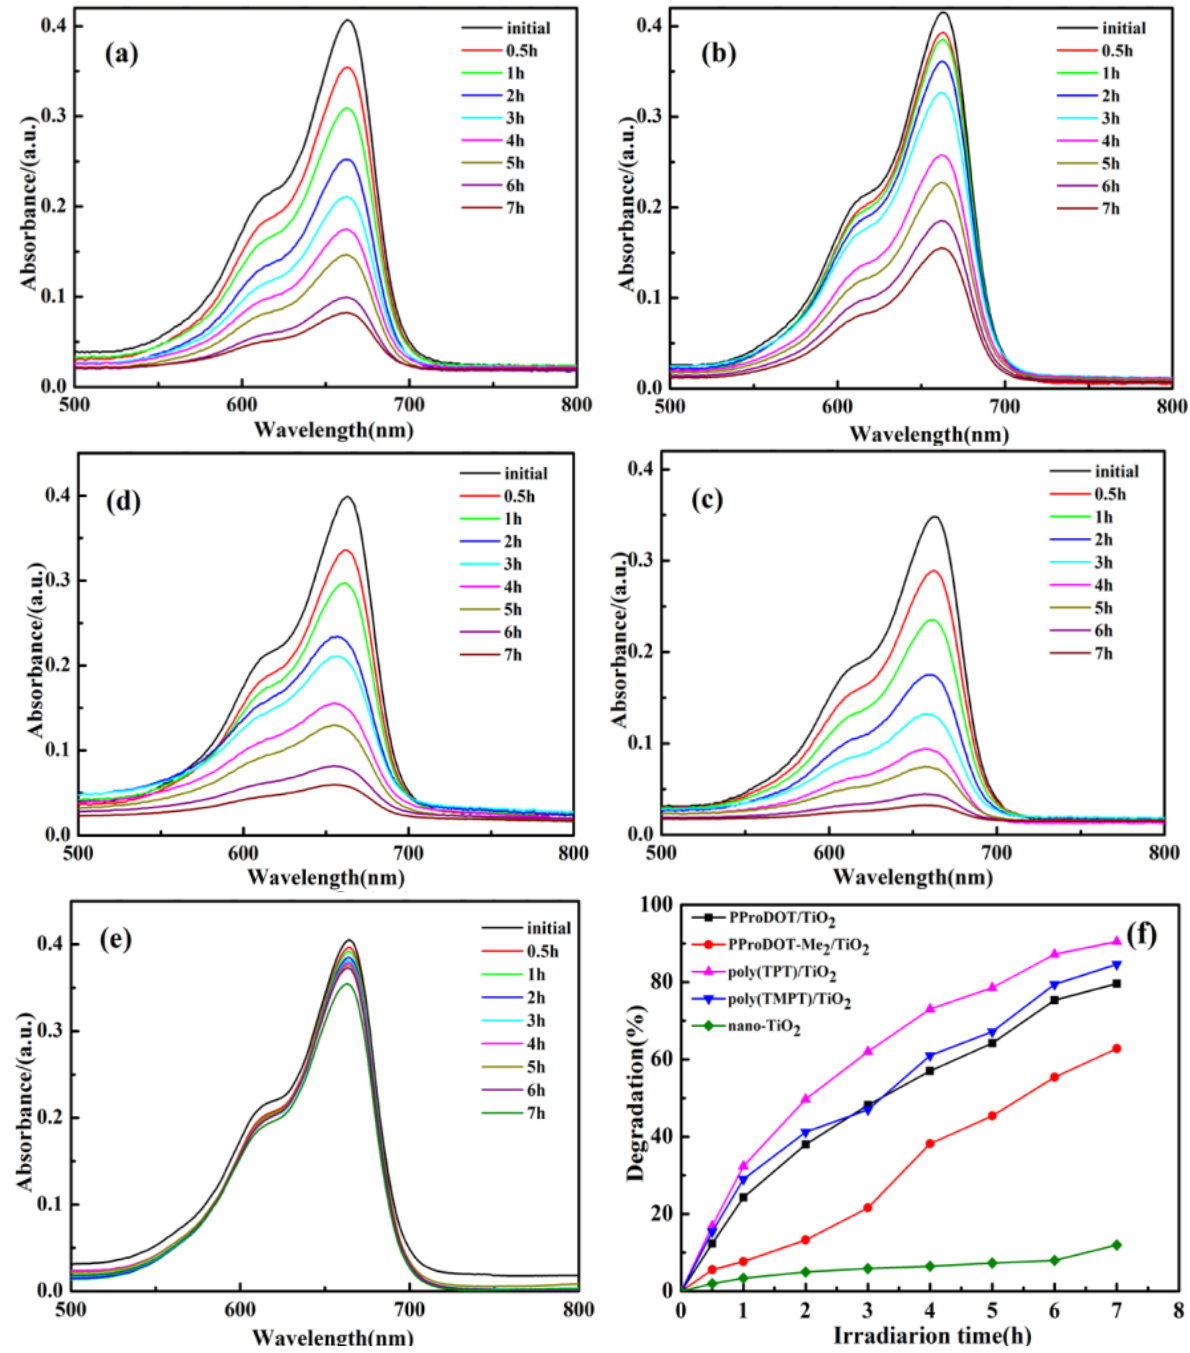
Figure 7. The UV-Vis absorption spectra of MB dyes by photocatalysis for different irradiation times under sunlight irradiation: ( a ) PProDOT/TiO ( c ) poly(TPT)/TiO ; ( d ) poly(TMPT)/TiO 2 efficiency of the MB dyes (catalyst concentration: 0.4 mg/mL; initial concentration of dyes: 1 × 10 −5